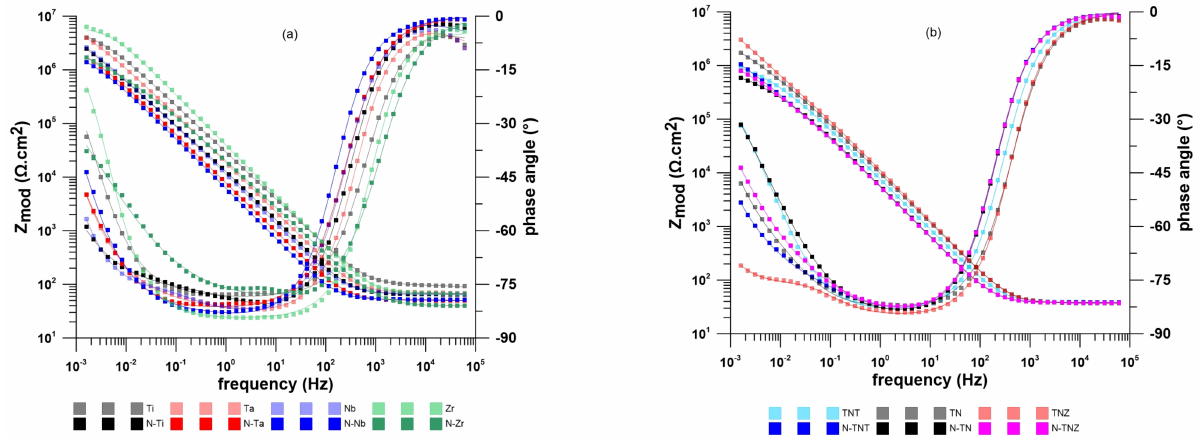
Figure 3. Impedance spectra after 12 h exposure of ( a ) elements and ( b ) alloys in physiological